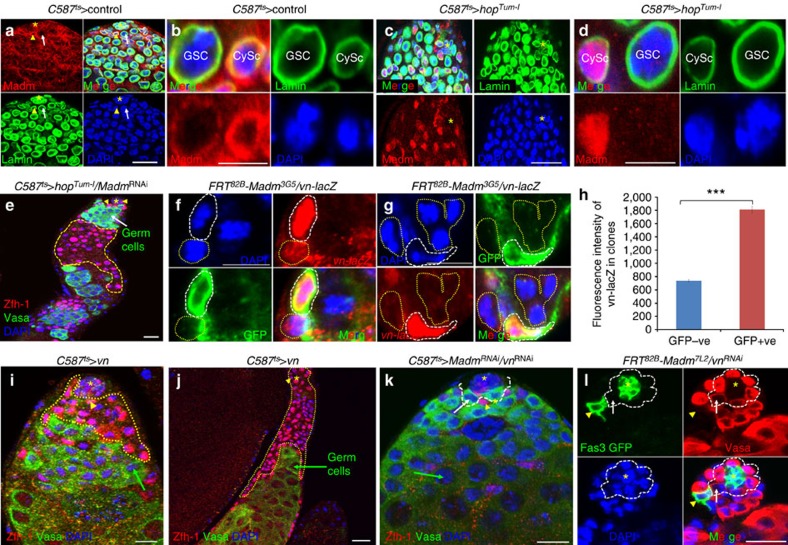
JAK signaling regulates the nuclear translocation of Madm, and Madm negatively regulates the EGFR/Ras/ERK signaling pathway by repressing vn expression.(a–d) The testes of C587ts> Control (6 days, a,b; n=15), C587ts>hopTum−l (6 days; c,d; n=32) were immunostained with the Madm (red), Lamin (red) and DAPI (blue). *indicate hub cells (a,c). GSC is highlighted by white arrows and CySCs are highlighted by yellow arrowhead (a,c). (e) The testes of C587ts>hopTum−l/MadmRNAi (6 days, n=25). Testes were cultured for 7 days at 29 °C before they were immunostained with Zfh-1 (red), Vasa (green) and DAPI (blue). (f,g) The testes of FRT82B-Madm3G5/vn-lacZ (n=33) were immunostained with β-galactosidase (vn-lacZ-red), GFP (green) and DAPI (blue). vn expression is markedly increased in GFP-positive Madm mutant CySCs (white dotted lines) compared with GFP-negative CySCs (yellow dotted lines). (h) A bar graph showing the quantitation of fluorescence intensity of vn-LacZ in FRT82B-Madm mutant clones. (i–k). Confocal sections of the testes containing C587ts>vn (i (70%) and j (30%); n=32); and C587ts>MadmRNAi/vnRNAi (k, n=30). The testes were cultured for 7 days at 29 °C before they were immunostained with Zfh-1 (red), Vasa (green) and DAPI (blue). (l) The testes of FRT82B-Madm7L2/vnRNAi (n=22) were immunostained 4 days ACI with GFP (green, yellow arrowhead), Fas3 (green, hub cells), Vasa (red) and DAPI (blue). vn knockdown in GFP-marked MARCM CySC clones of Madm mutant significantly (Student's t-test, P<0.0001) suppress the phenotypes associated with Madm knockdown. Green arrows indicate differentiated germ cells (e,i,j). Yellow arrowhead indicate CySCs (e,i–l). GSC are highlighted by white arrows (white dotted lines, k,l). Yellow dotted lines indicate Zfh-1-positive cells (e,i,j). *indicate hub cells. All values are mean±s.e.m. Statistical significance determined by Student's t-test, ***P<0.0001. Scale bar, 10 μm (a–h).